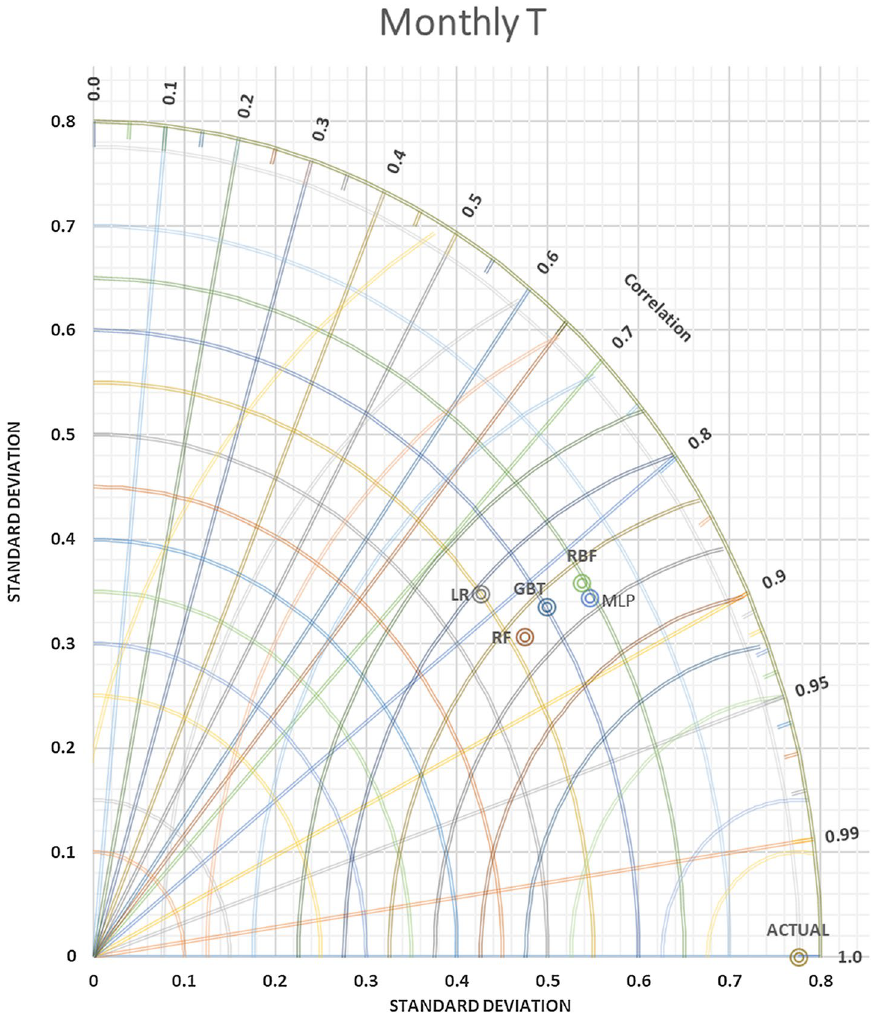
Figure 11. Taylor diagram of predicting monthly T amounts using the most accurate